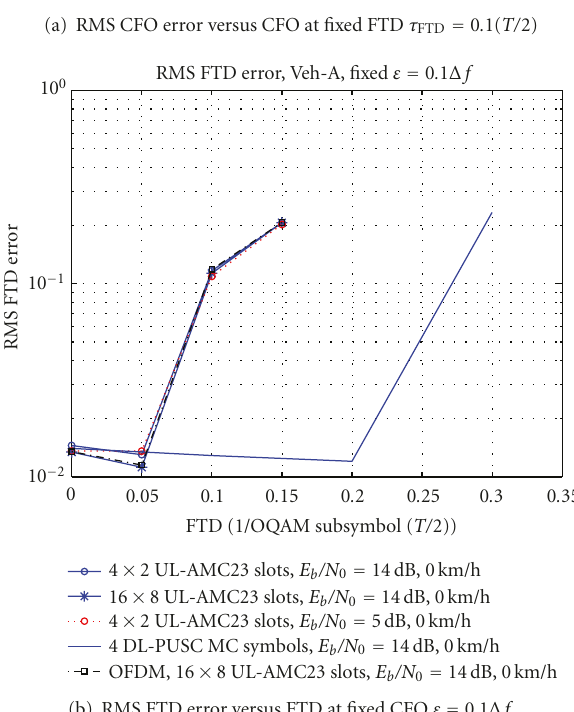
Figure 11: RMS errors in CFO and FTD estimation in AMC23 and DL-PUSC transmission with di ff erent burst sizes. E b /N 0 values are referred to 4-QAM modulation.